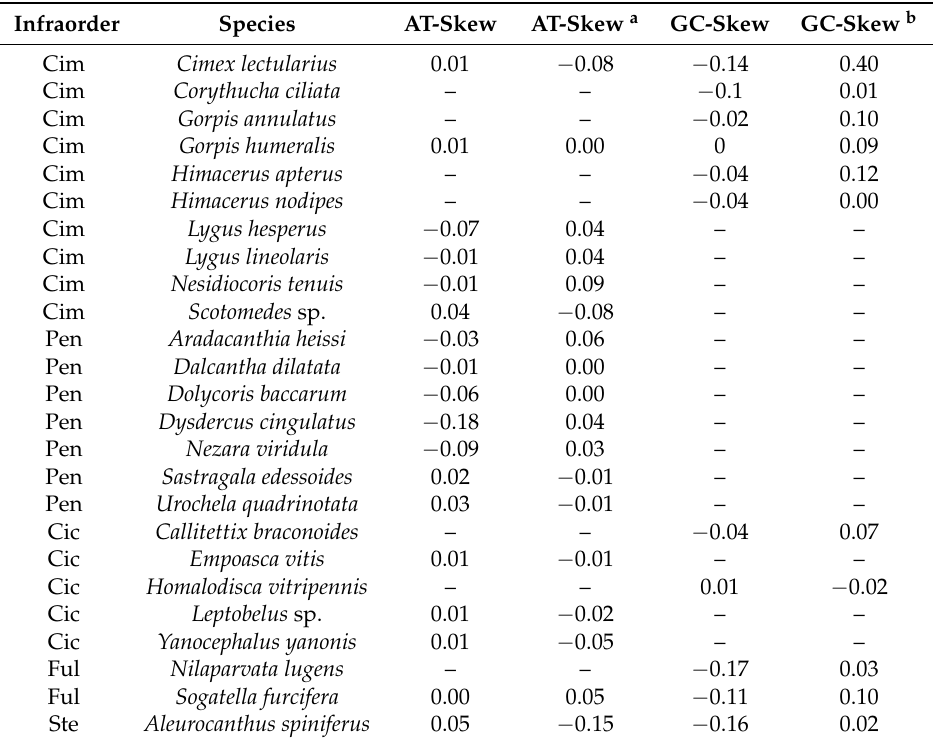
Table 3. The shift to an AT- or GC-skew of CRs in Hemiptera.